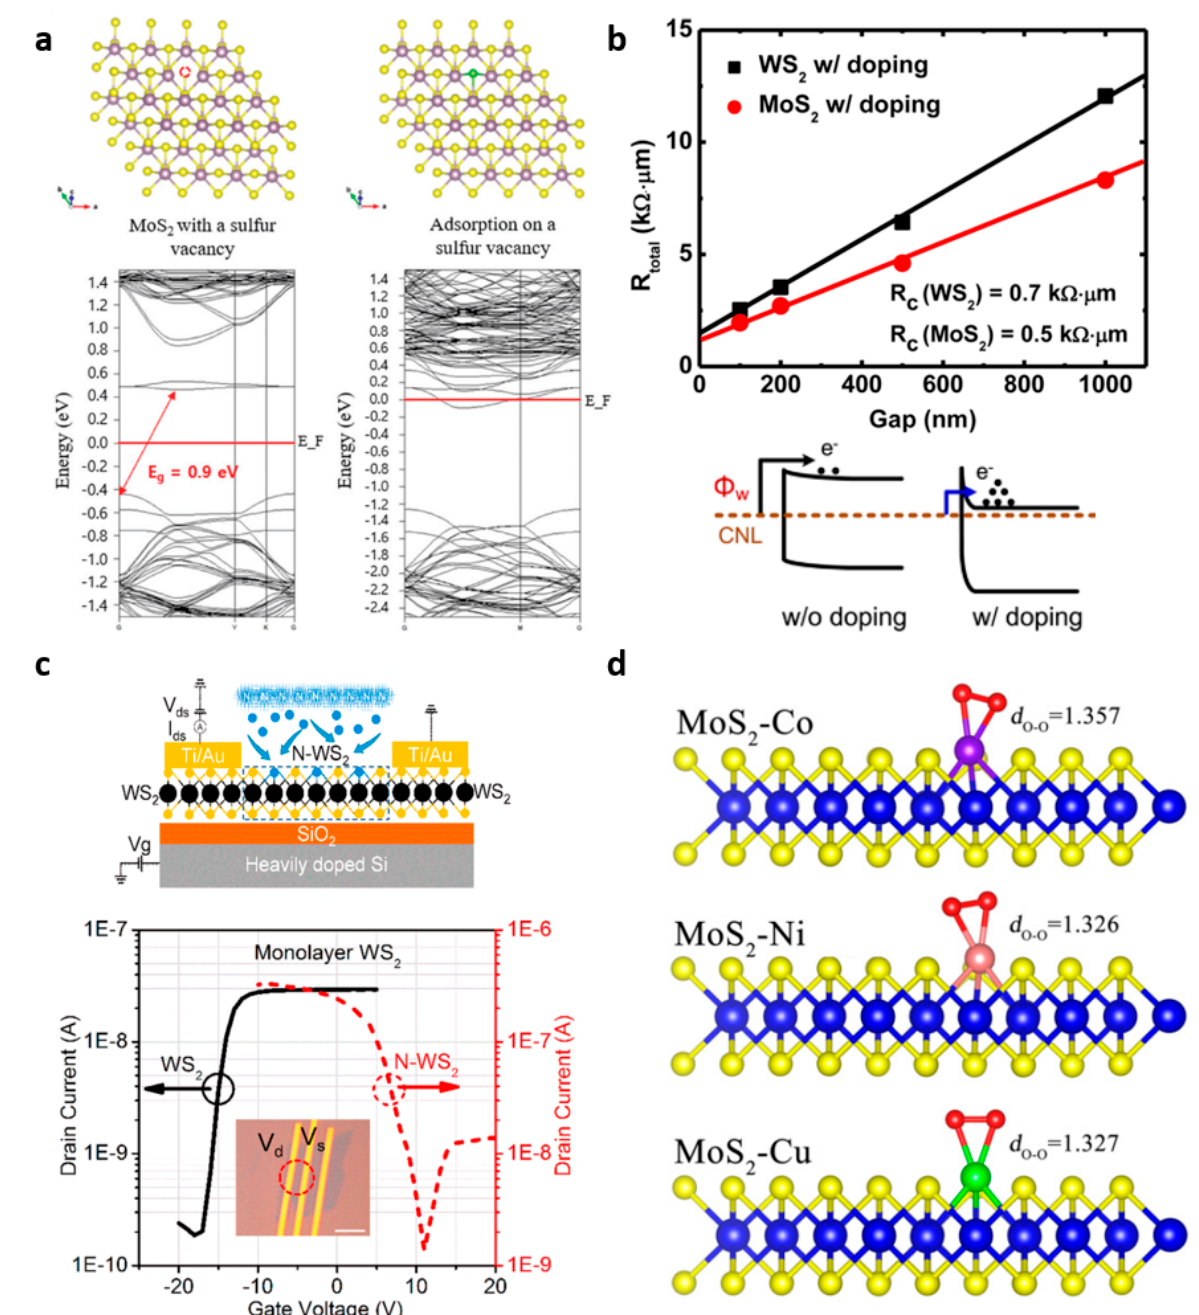
Figure 5. ( a ) Change in band structure for adsorption of chlorine atom on S vacancy of MoS 2 (adapted from [64] with permission from Royal Society of Chemistry). ( b ) Transfer length method (TLM) resistances of Cl-doped WS 2 and MoS 2 and schematic band diagram of metal-transition metal dichalcogenide (TMD) contacts with and without chloride doping (adapted from [62] with permission from ACS publications). ( c ) Transfer characteristics at V DS = 1 V for pristine WS 2 and N-WS 2 transistors (adapted from [63] with permission from ACS publications). ( d ) Geometric structure and charge density difference for intermediate OOH adsorption on the hydrogenated MoS 2 -TM (Co, Ni and Cu) system; the gray, red, violet, pink, green, blue, and yellow spheres represent H, O, Co, Ni, Cu, Mo and S atoms, respectively (adapted from [61] with permission from Elsevier).